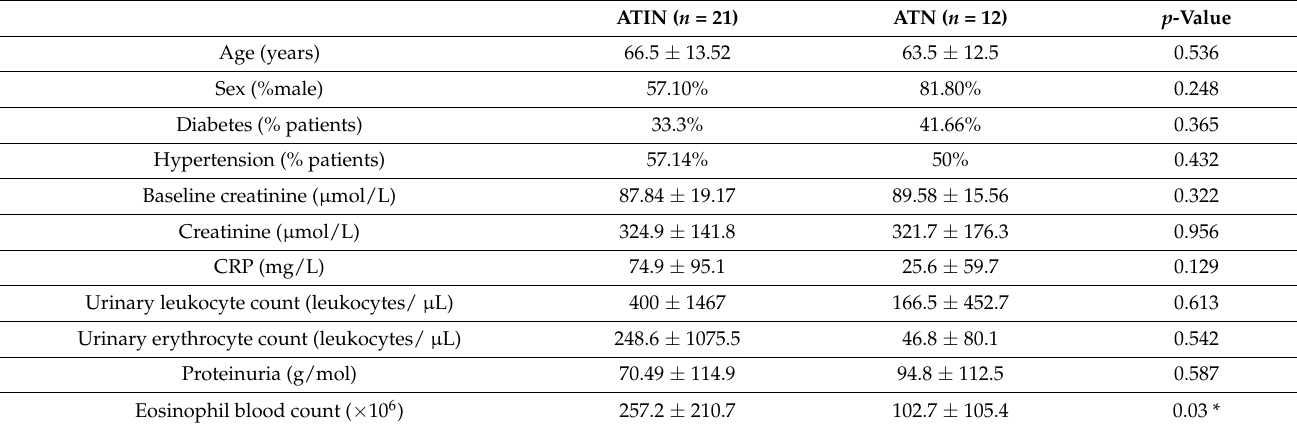
Table 1. Baseline characteristics of the ATIN and ATN cohorts. * Statistically significant differences. CRP—C reactive protein. ATIN—acute tubulointerstitial nephritis; ATN—acute tubular